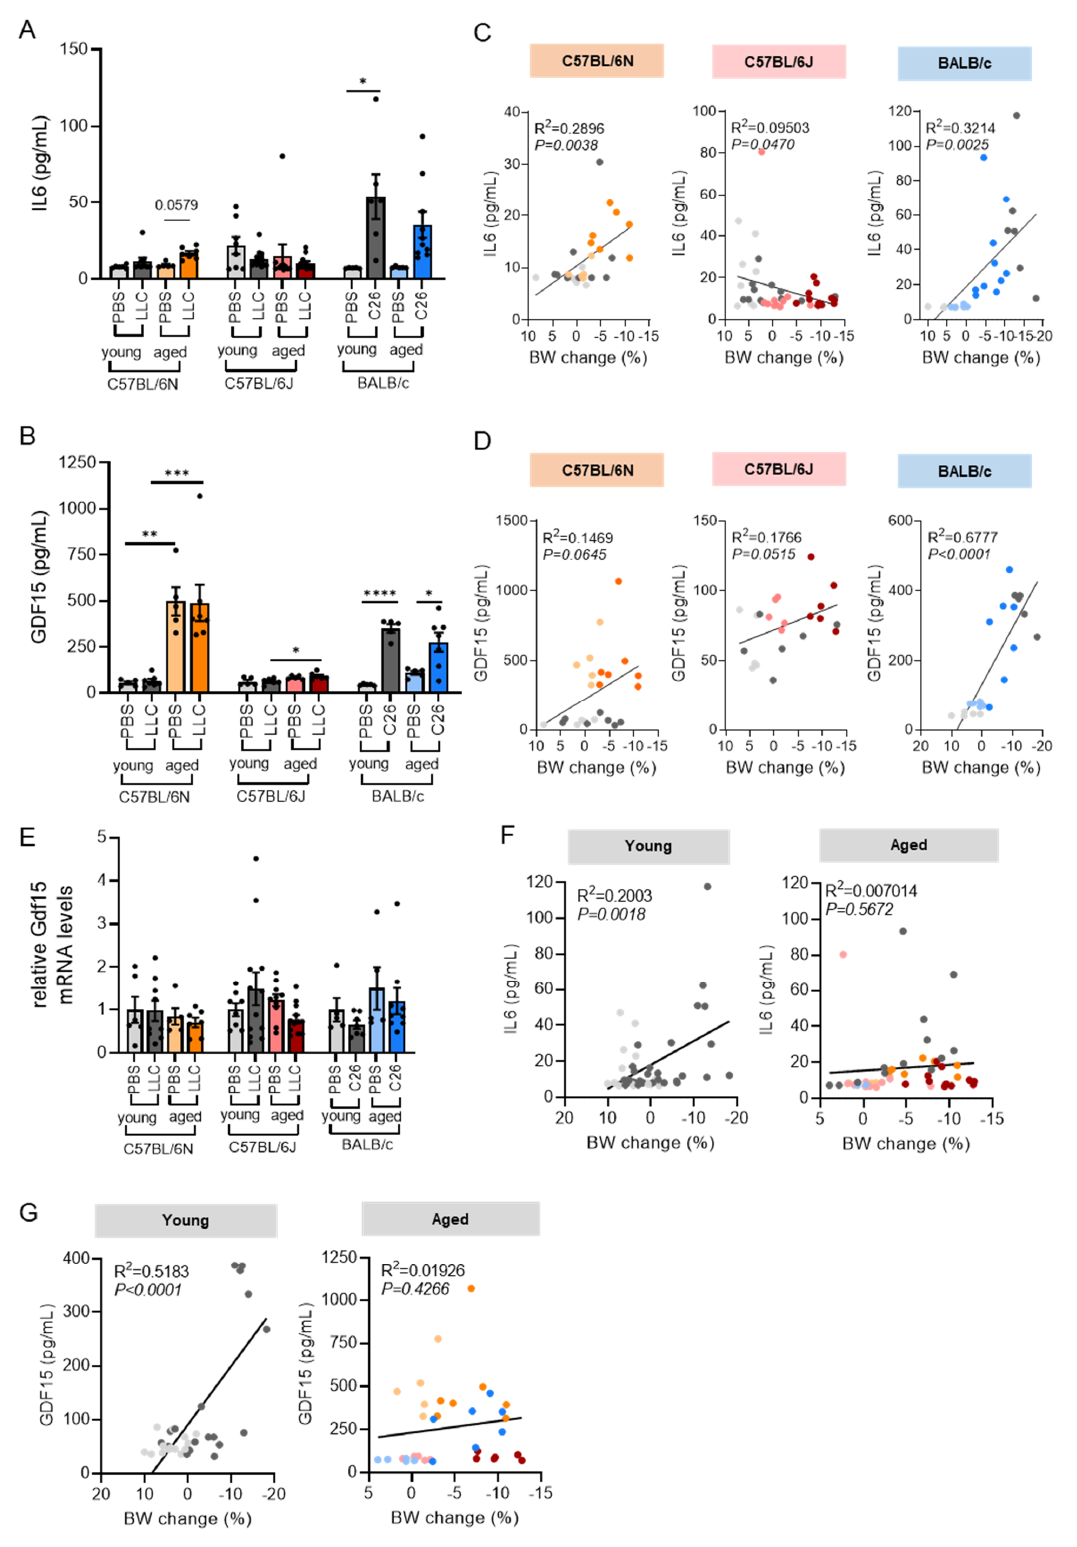
Figure 6. Circulating IL6 and GDF15 levels are cachexia markers in C26 mice. ( A – G ) Same mice as in Figure 2. ( A , B ) Circulating levels of interleukin 6 (IL6) ( A ) and growth differentiation factor 15 (GDF15) ( B ) in young and aged mice. ( C , D ) Linear regression analyses comparing plasma IL6 ( C ) or GDF15 ( D ) levels and body weight change (final body weight minus tumor compared to initial